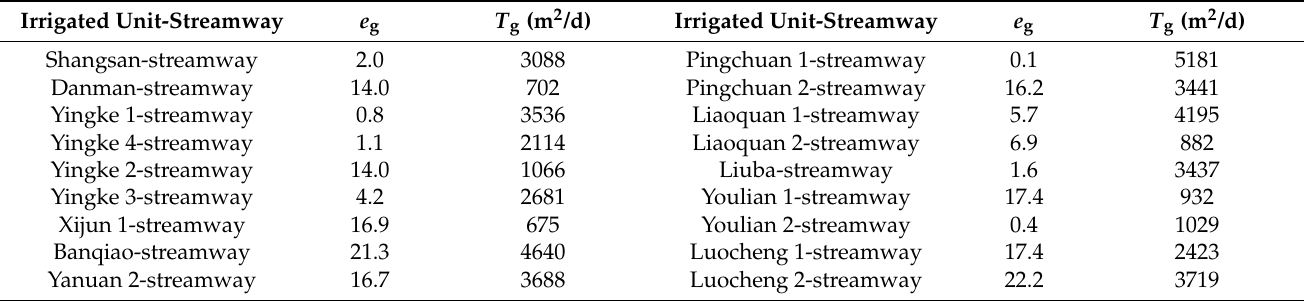
Table 4. The optimal value of the width-to-length ratio and the coefficient of water conductance between the irrigated area and the